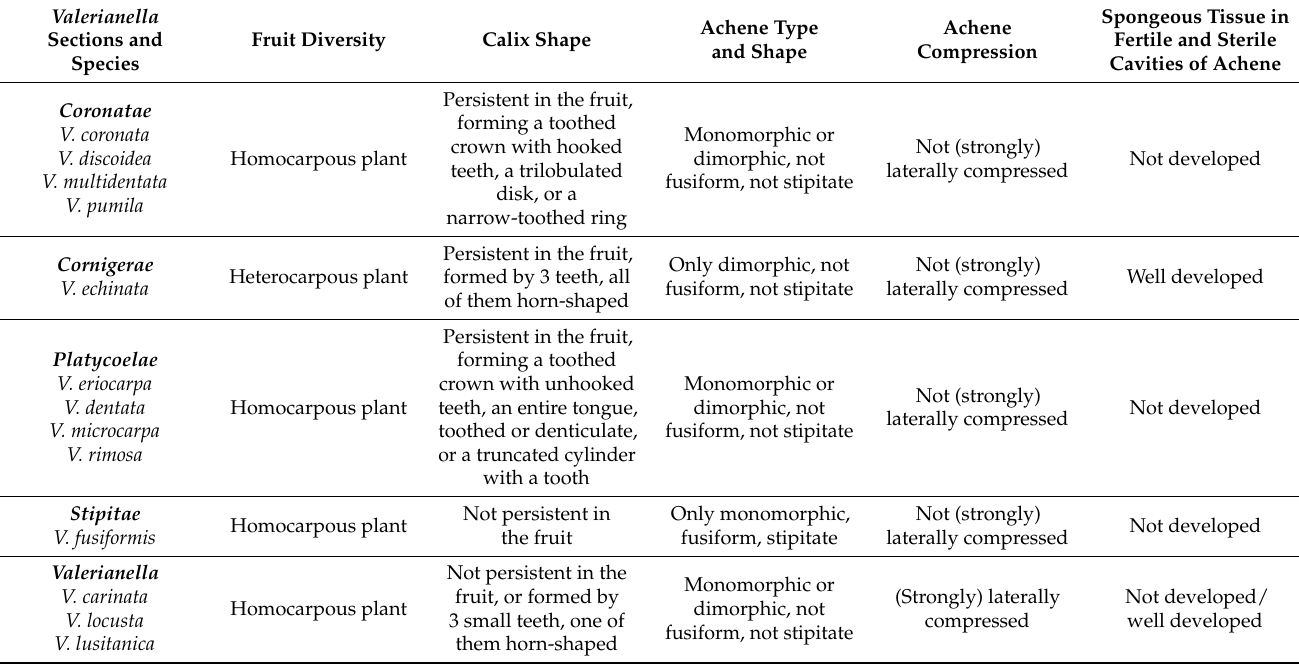
Table 1. A summary of the carpological diagnostic features characterizing the four main sections of Valerianella ( V . sects. Cornigerae , Coronatae , Platycoelae , and Valerianella ) and the newly described V . sect. Stipitae analyzed in this